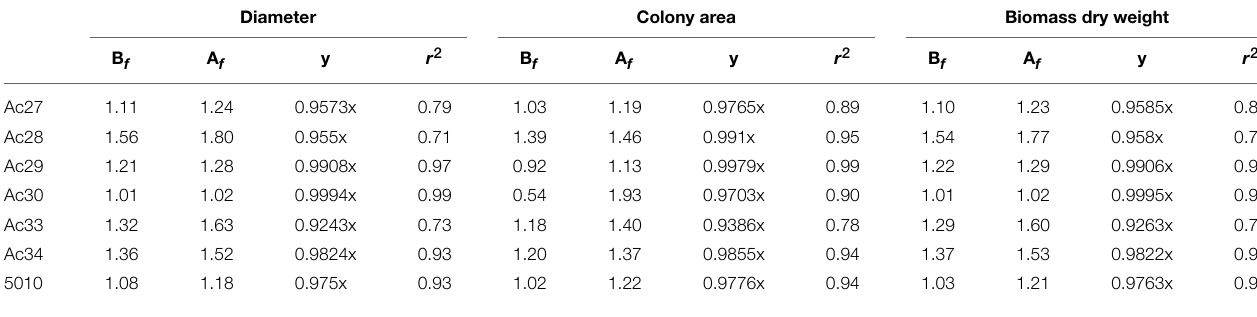
TABLE 6 | Accuracy and Bias factors arising from OTA data Diameter Colony area Biomass dry